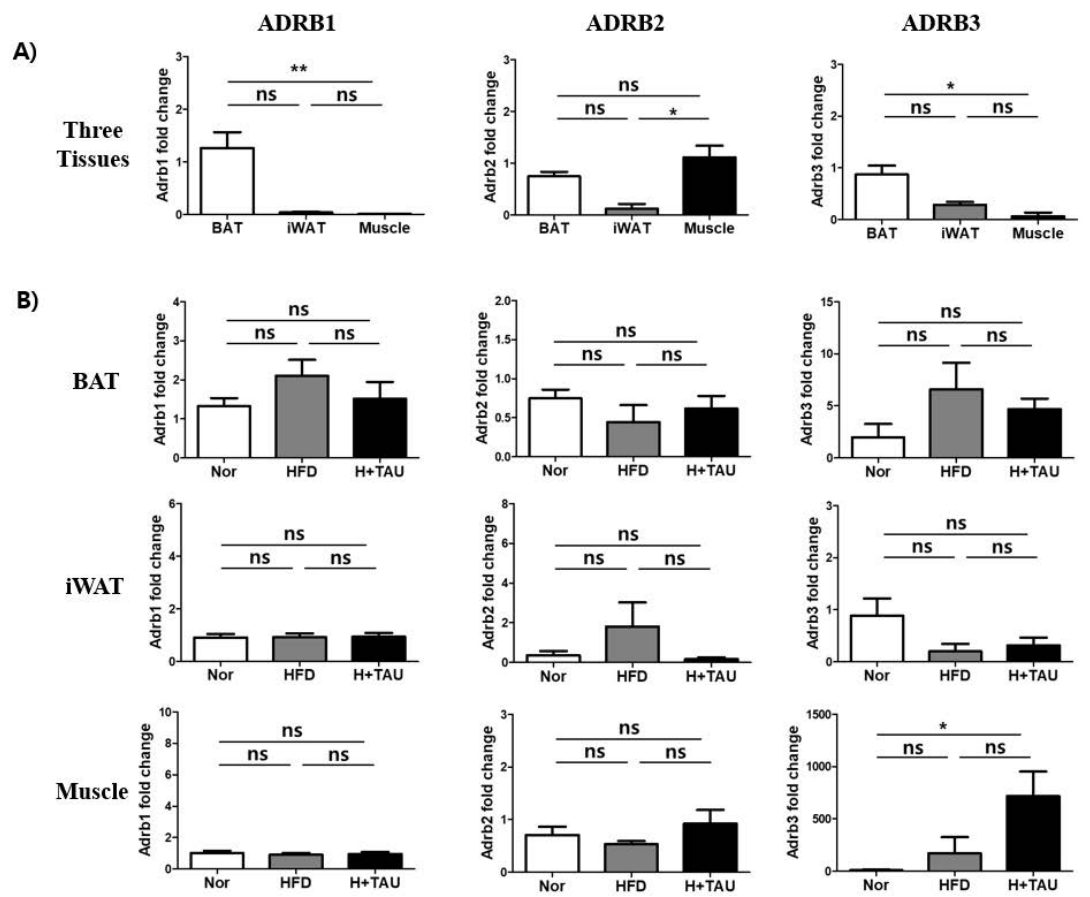
Figure 3. The e ff ects of taurine on the transcriptional expression of β 1, 2, 3 -adrenergic receptors in tissues. ( A ) The relative basal mRNA expression levels of three subtypes of β 1, 2, 3 -adrenergic receptors ( ADRB1 , ADRB2 , and ADRB3 ) were compared in the three tissues of the normal diet (N) group. ( B ) The mRNA expression levels were compared to determine if HFD and / or taurine supplementation a ff ected gene expression in each tissue of the three groups: N normal diet group ( n = 5), HFD high-fat diet group ( n = 5), and H + Tau HFD + taurine (2% in drinking water) group ( n = 5). Di ff erences between the three groups were analyzed using the nonparametric Kruskal–Wallis test as described in Figure 2. Di ff erences were considered statistically significant at p < 0.05. ** p < 0.01; * p < 0.05; ns not